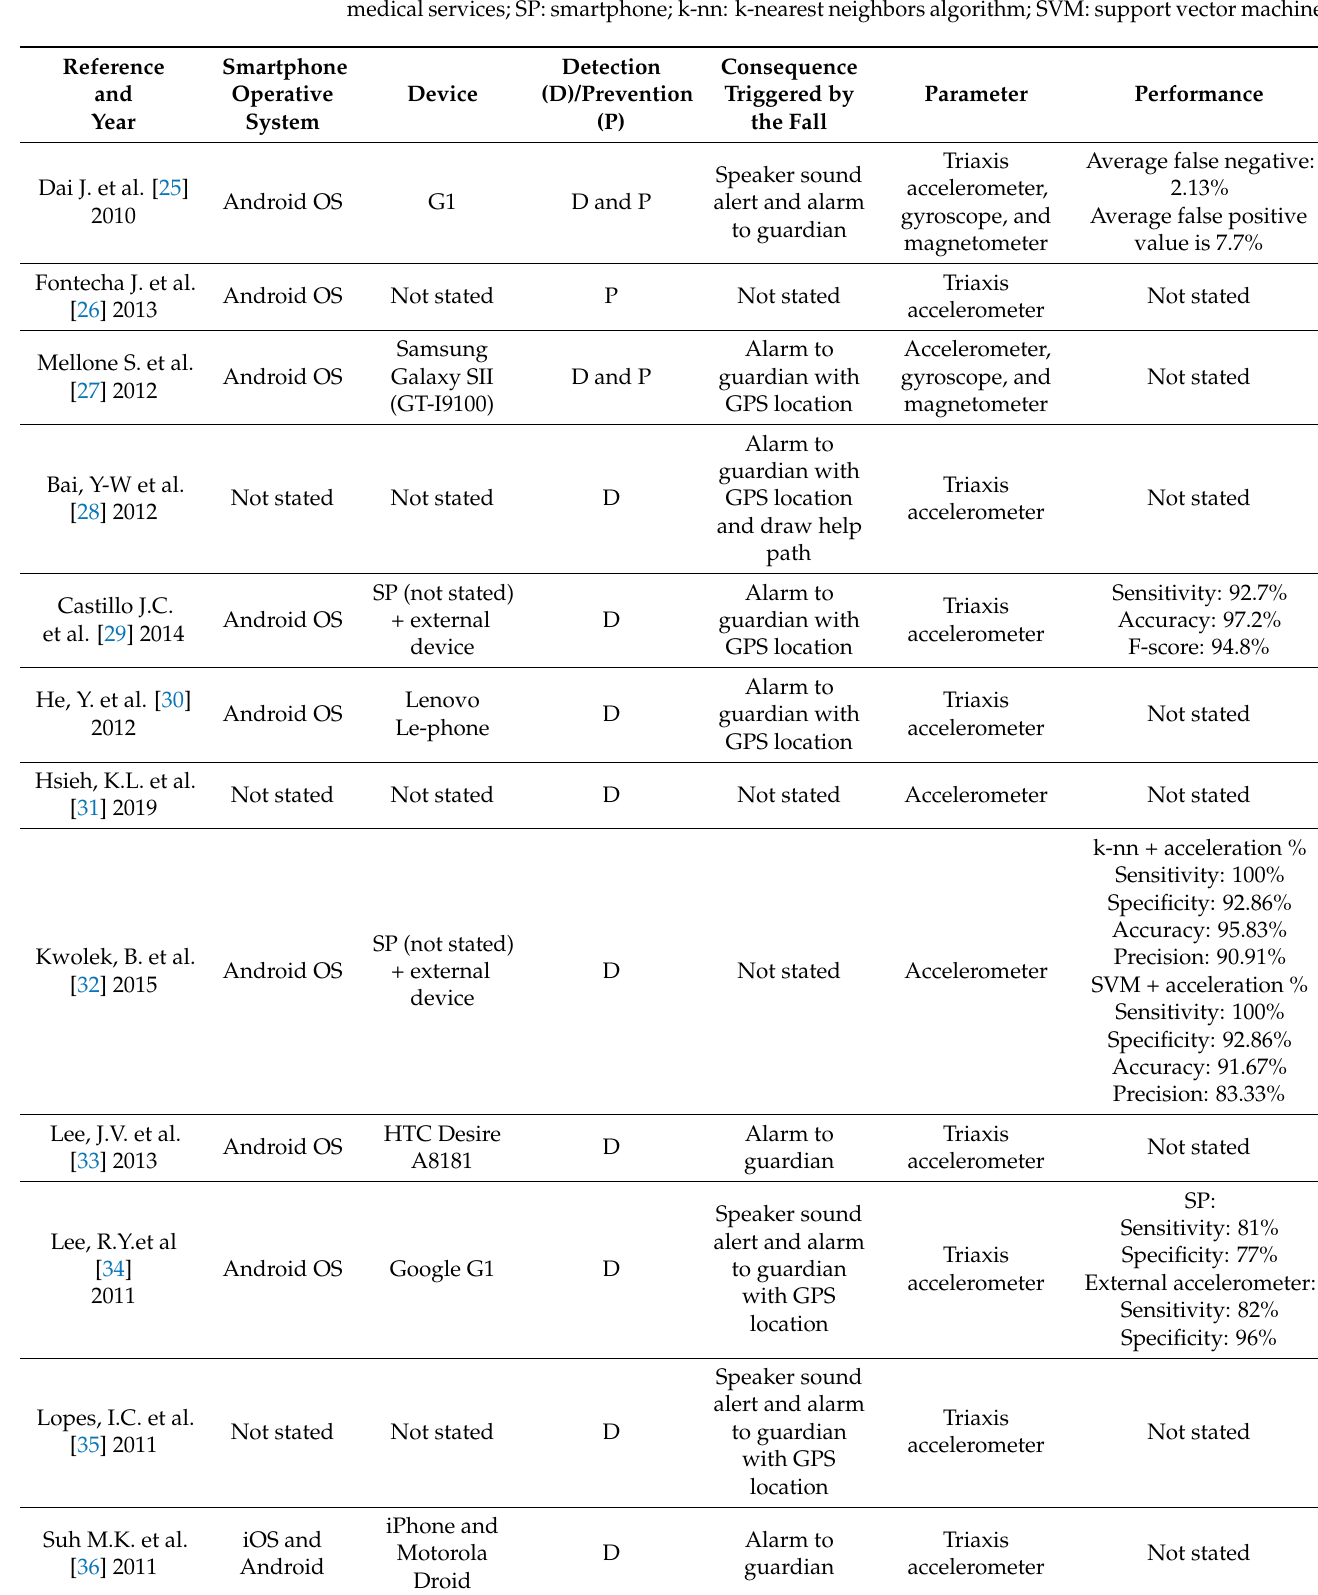
Table 1. Description of studies that aimed to detect accidental falls. Abbreviations: EMS: